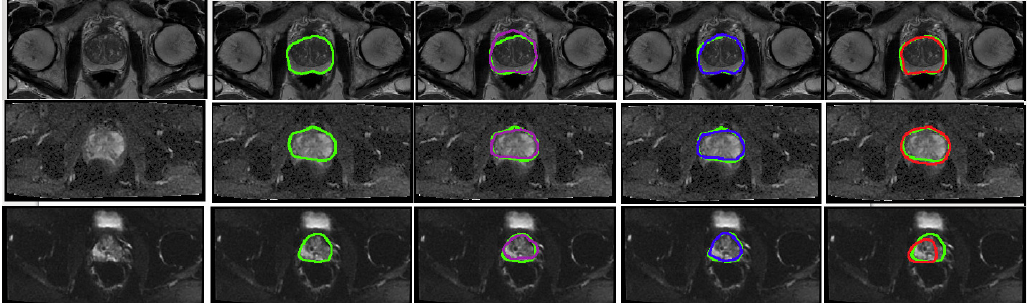
Figure 5. Visual representation of the predicted segmentation for each model and each modality for a single slice from a case study. From the top row to the bottom: T2W, ADC and DWI. From left to right: Raw test image, Ground truth boundaries in green, U-Net’s prediction in purple, cGAN’s prediction in blue and cycleGAN prediction in red. The quantitative results show the best performance for cGAN followed by U-Net for all evaluation metrics. Scaled images are shown in Figure A1 for better